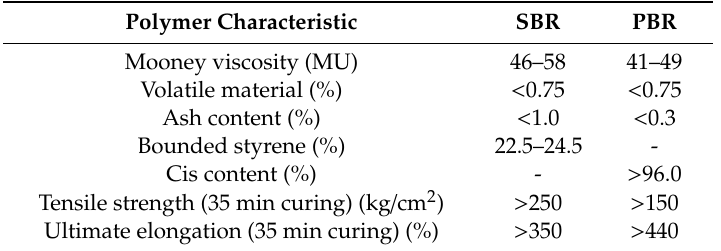
Table 1. Technical characteristics of employed premium quality